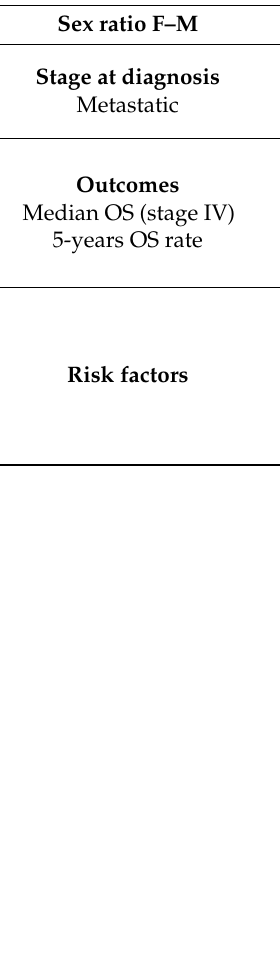
Table 2. Immunohistochemical features between MiT family tRCC and their main differential